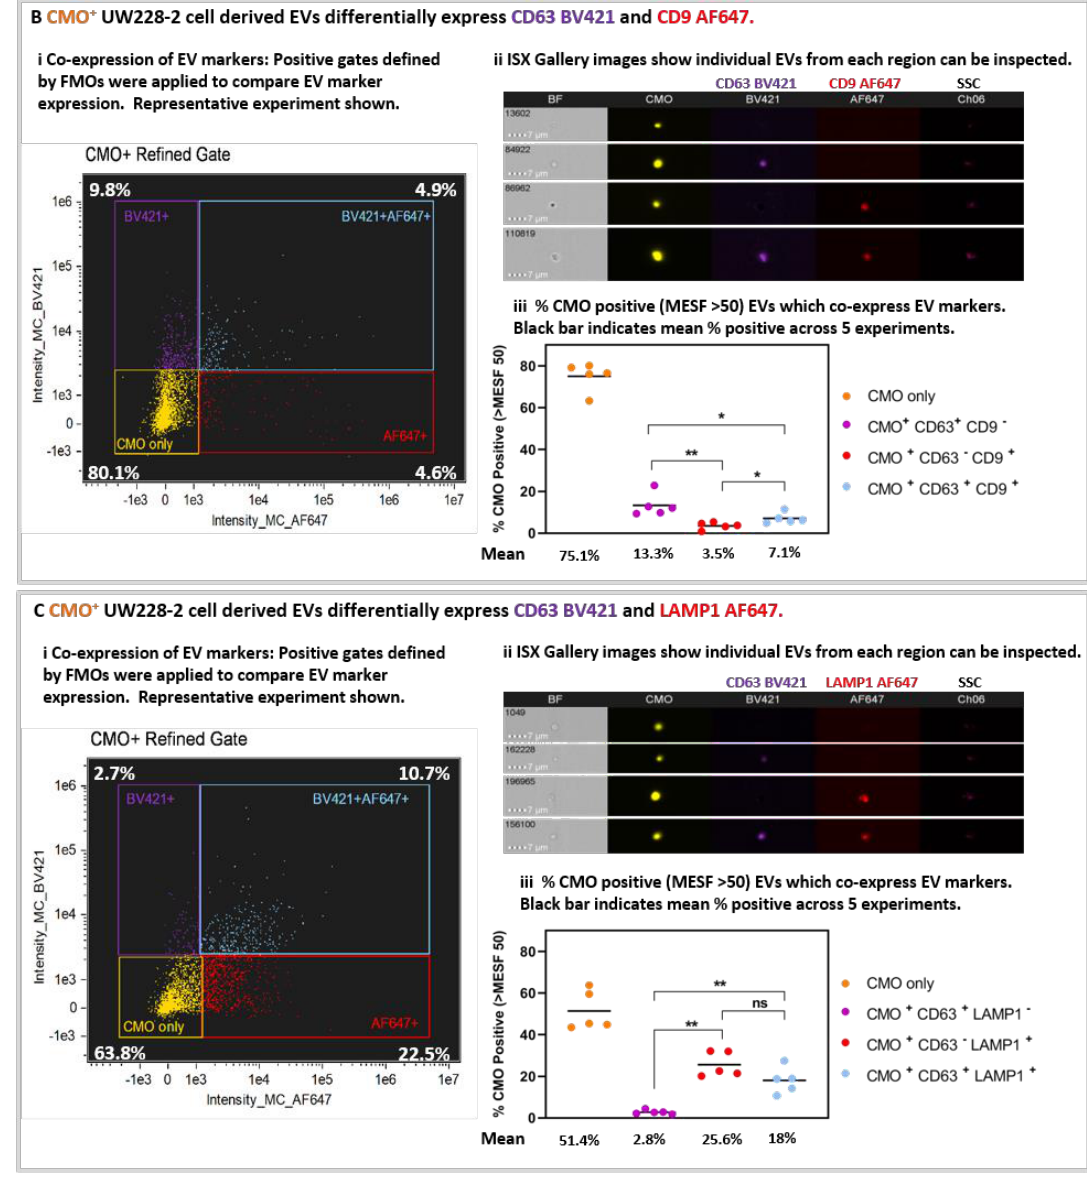
Figure 5. Isolated large EVs can be triple-labelled and individual events can be scrutinised post-acquisition. ( A ) The proportion of CMO + events expressing a single EV marker varied across replicates. The percentage positive events within the CMO + MESF > 50 gate which expressed either no EV marker (CMO only), CD63, CD9, or LAMP1 varied across replicates. Black bar represents the mean across 10 (CMO or CD63) or 5 (CD9 or LAMP1) replicates. CMO only 63.3% ( ± 4.6 SEM), CD63 only 19% ( ± 2.2 SEM), CD9 ( ± 0.5 SEM) only 10.3% and LAMP1 only 47.6% ( ± 3.8 SEM). ( B ) UW228-2 cell derived EVs di ff erentially express EV markers CD63 and CD9, or both. EVs were labelled with CMO, CD63 BV421 and CD9 AF647. CMO + events (MESF > 50) were analysed for co-expression with CD63, CD9 or both. Quadrant gating of bivariate plots for fluorescence intensity in channel 07 (BV421) and channel 11 (AF647) demonstrated single labelled (CMO + only), dual and triple labelled EV populations (i). Percentage positive in each quadrant is shown. Representative experiment. Gallery images display examples of individual events from each of the 4 quadrants (ii). Bright Field (BF) and side scatter (SSC) channels are shown alongside CMO, CD63 BV421 and CD9 AF647. Of the CMO + MESF > 50: 75.1% ( ± 3.0 SEM) were CMO + only; 13.3% ( ± 2.4 SEM) expressed CD63 BV421 and 3.5% ( ± 0.8